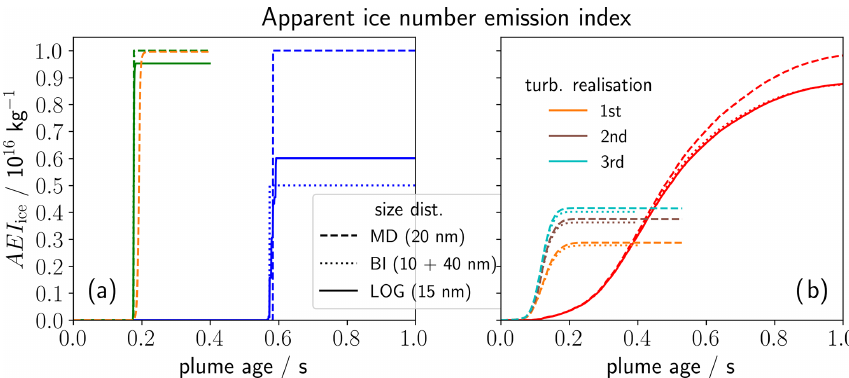
Figure 6. Temporal evolution of the apparent ice number emission index under baseline conditions of Lewellen (2020, “Lew20”) as sum- marized in the bottom half of Table 1. The simulation initialization uses a monodisperse (dashed), bidisperse (dotted) or log-normal (solid) size distribution of soot particles (see also inserted legend). Panel (a) juxtaposes the FLUDILES based average traj evolution (blue) with the evolution using Lew20’s dilution (green) and with the results of Lew20’s box model (orange). Lew20’s data are available up to a plume age of 0.4s. Note that the dashed and dotted green lines are mostly covered by the solid green line. Panel (b) depicts the FLUDILES ensemble mean evolution (red lines) with the LES results from Lew20’s Fig. 2 for three different turbulent realizations (remaining